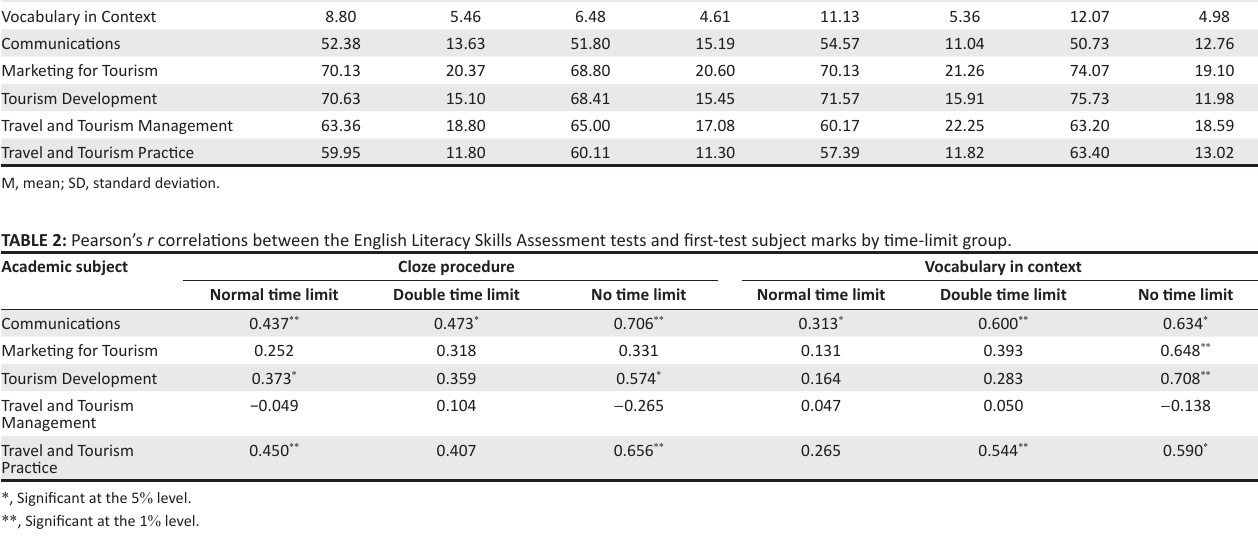
homogeneity of variance met the required assumption of equal variances ( F = 0.100, p = 0.905). The significant differences were identified as involving the normal time-